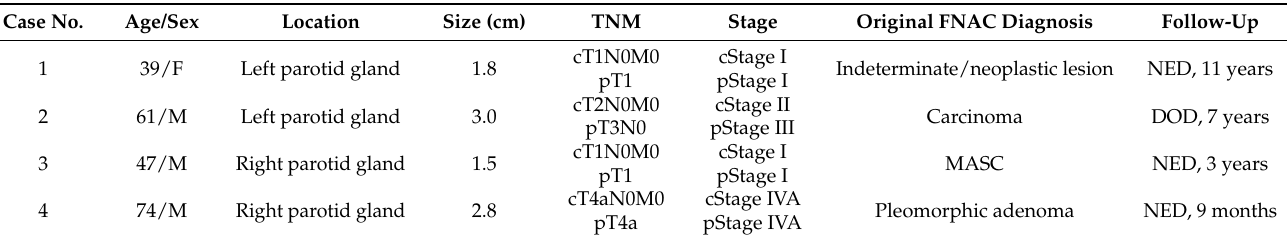
Table 1. Clinicopathological features of secretory